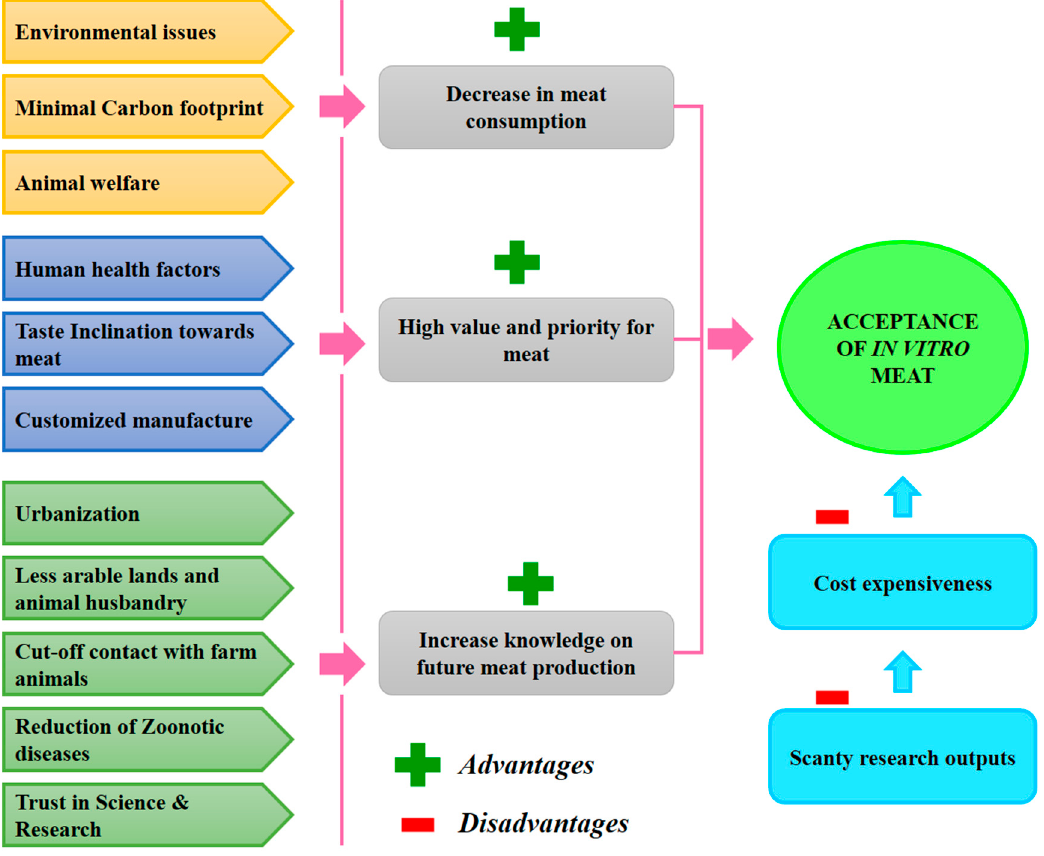
Figure 3. The agenda underpinning the promotion and acceptance of artificial meat.